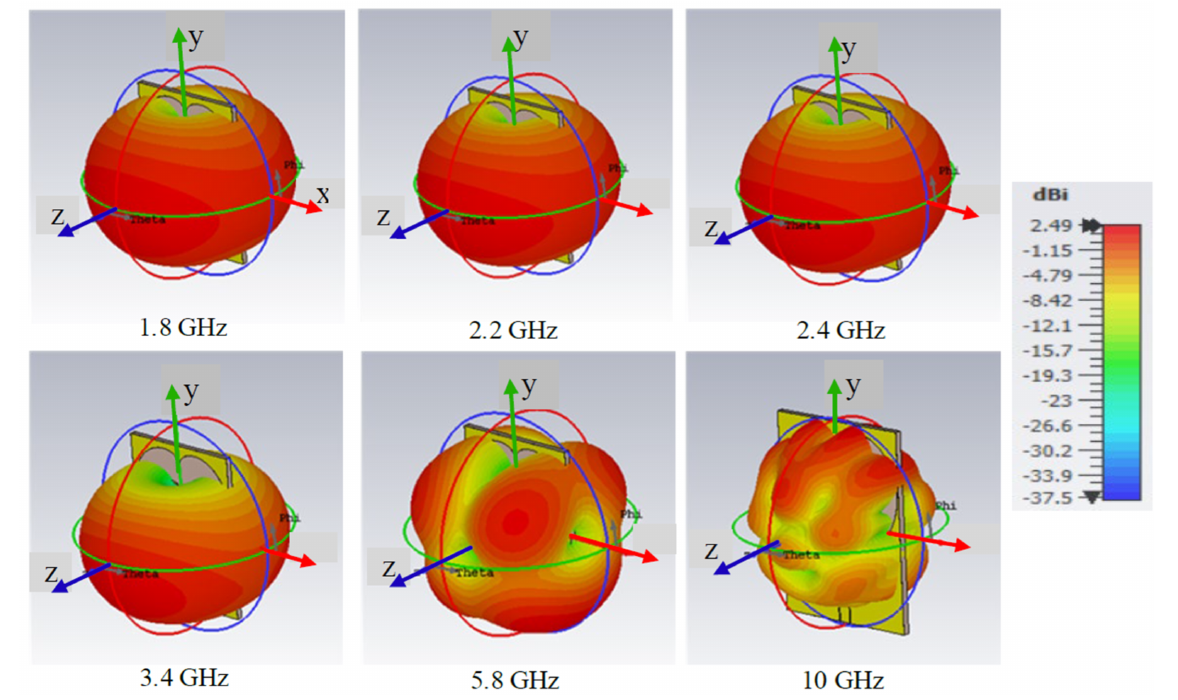
Figure 9. Three-dimensional representation of the simulated radiation patterns.